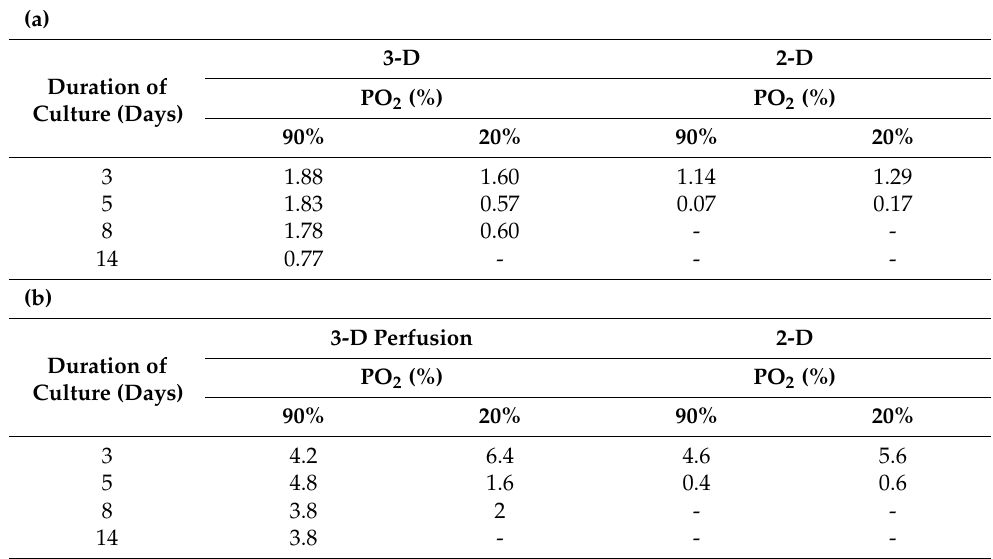
Table 2. Contraction of mouse colorectal explants during long-term culture. (a) Average observable contraction per minute. (b) The maximum number of contractions per minute observable through brightfield microscopy. The data show a comparison between 3D vs. 2D culture at two oxygen partial pressures (20% and 90%). The explants cultured in 3D were able to maintain the contraction for 14 days, while those in 2D culture stopped the motion after 5 days of